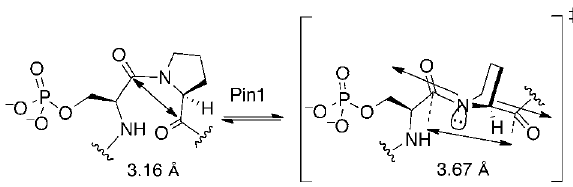
Figure 6. Pin1 is proposed to stretch the prolyl ring by binding phosphate and C-terminal residues tightly, creating a trans - pyrrolidine conformation of the substrate and forcing pyr- amidalization of the prolyl nitrogen in the twisted-amide mechanism. Distance measurements are from calculated structures of Ac–Pro–OH in the ground state and the trans -pyrrolidine transition state.